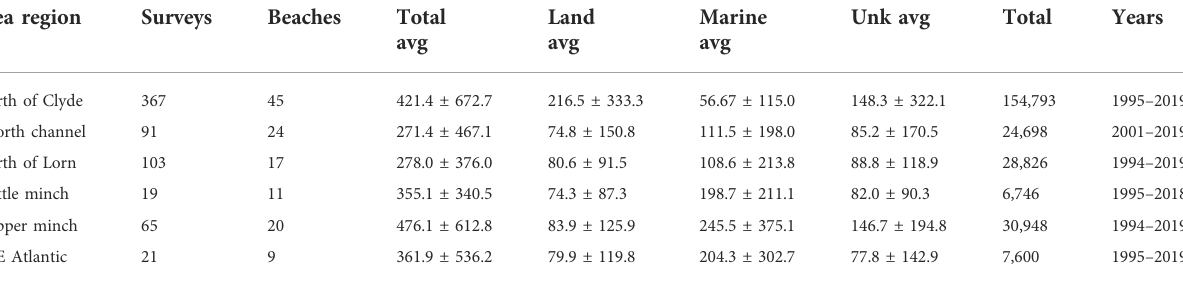
TABLE 1 A descriptive table of the average (avg) ± standard deviation, of plastic items per 100 m transect in each of the following sea-regions, within the sub-area. Sea-regions are presented following the fl ow of the Scottish Coastal Current (SCC), starting from the Firth of Clyde, and going